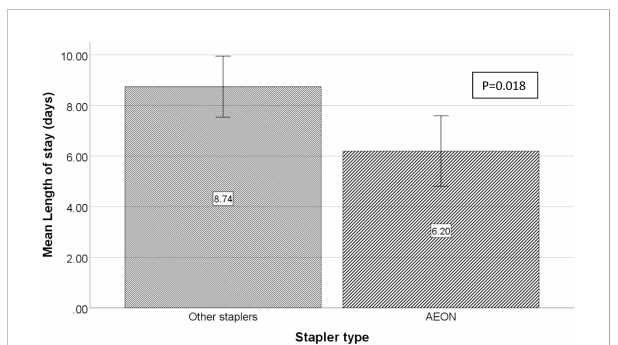
FIGURE 4 Comparison of mean length of stay between AEON and other staplers used for pancreatic transection. The mean length of stay was shorter by 4 days in the AEON group compared with that in the other instrument (6 and 9 days, respectively; p = 0.018).